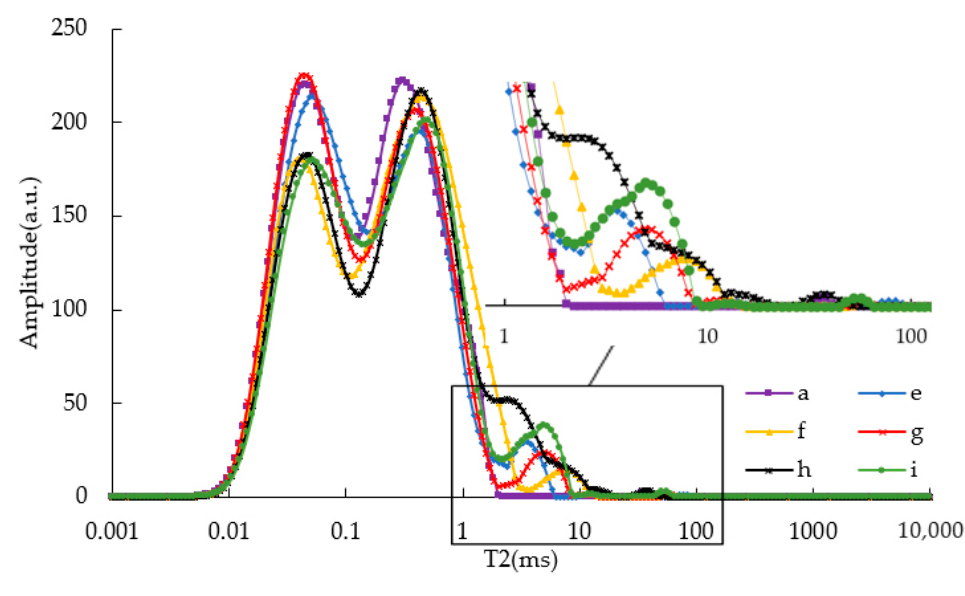
Figure 6. T2 of CRM asphalt binders unaged.